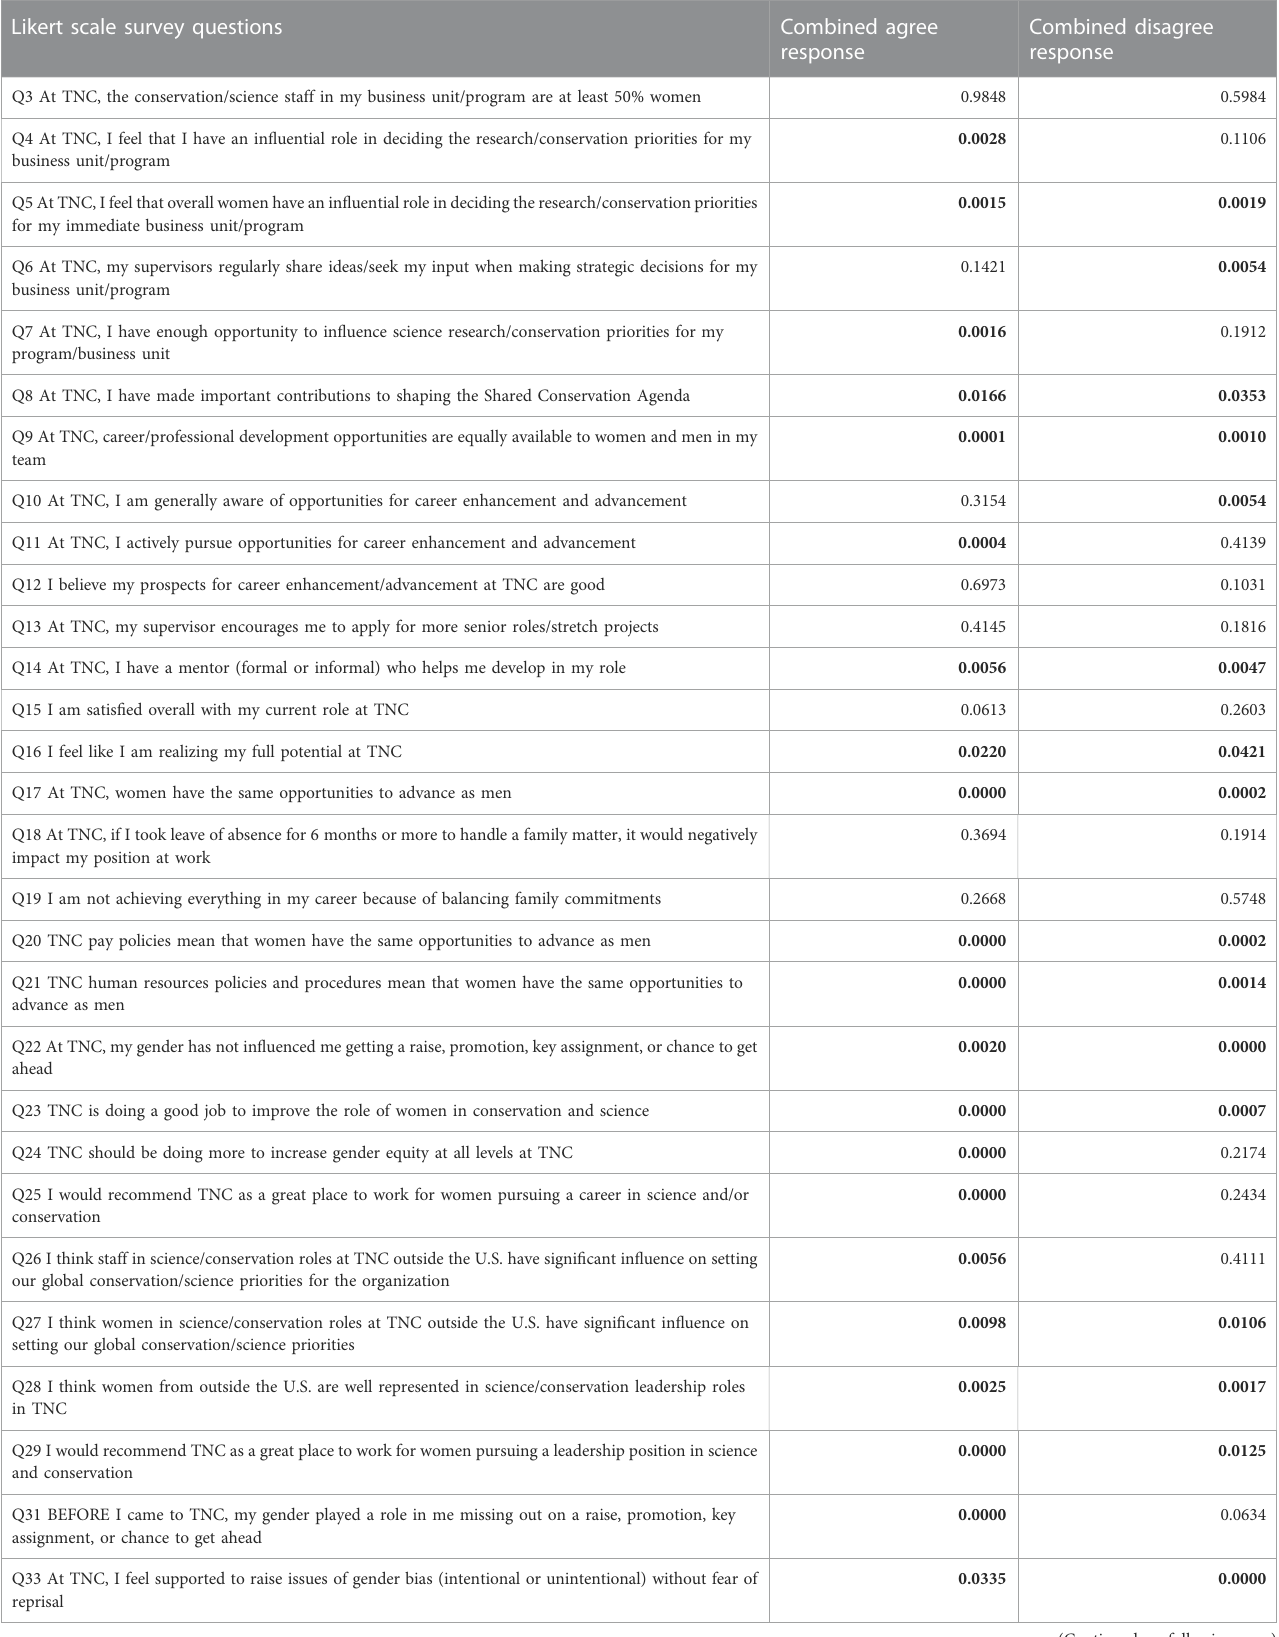
TABLE 1 Multinomial logistic regression analysis p -values indicating signi fi cant differences ( p < 0.05; in bold) for the Likert question responses between women and men. “ Agree ” and “ Strongly agree, ” and “ Disagree ” and “ Strongly disagree, ” were aggregated to give “ combined agree ” and “ combined disagree. ” Of the 32